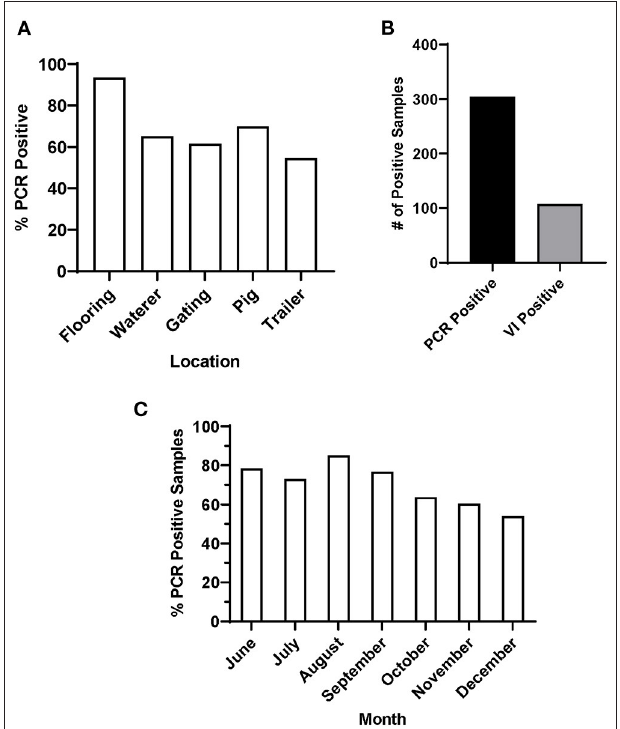
FIGURE 1 | PCR and VI results of environmental samples from Plants 1-3. (A) Percentage of SVA positive samples by sample location, (B) total number of SVA PCR positive and VI positive samples and (C) percentage of SVA positive samples by